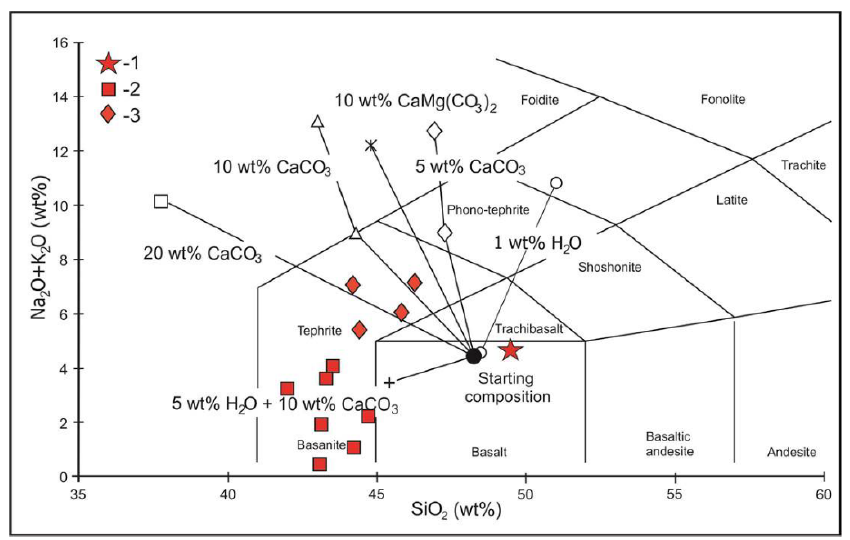
Figure 16. Residual glasses from experiments of Mollo et al. [30] and Tazheran samples in TAS diagram. 1 = dolerite; 2 = pyroxenite; 3 = nepheline-fassaite rock.